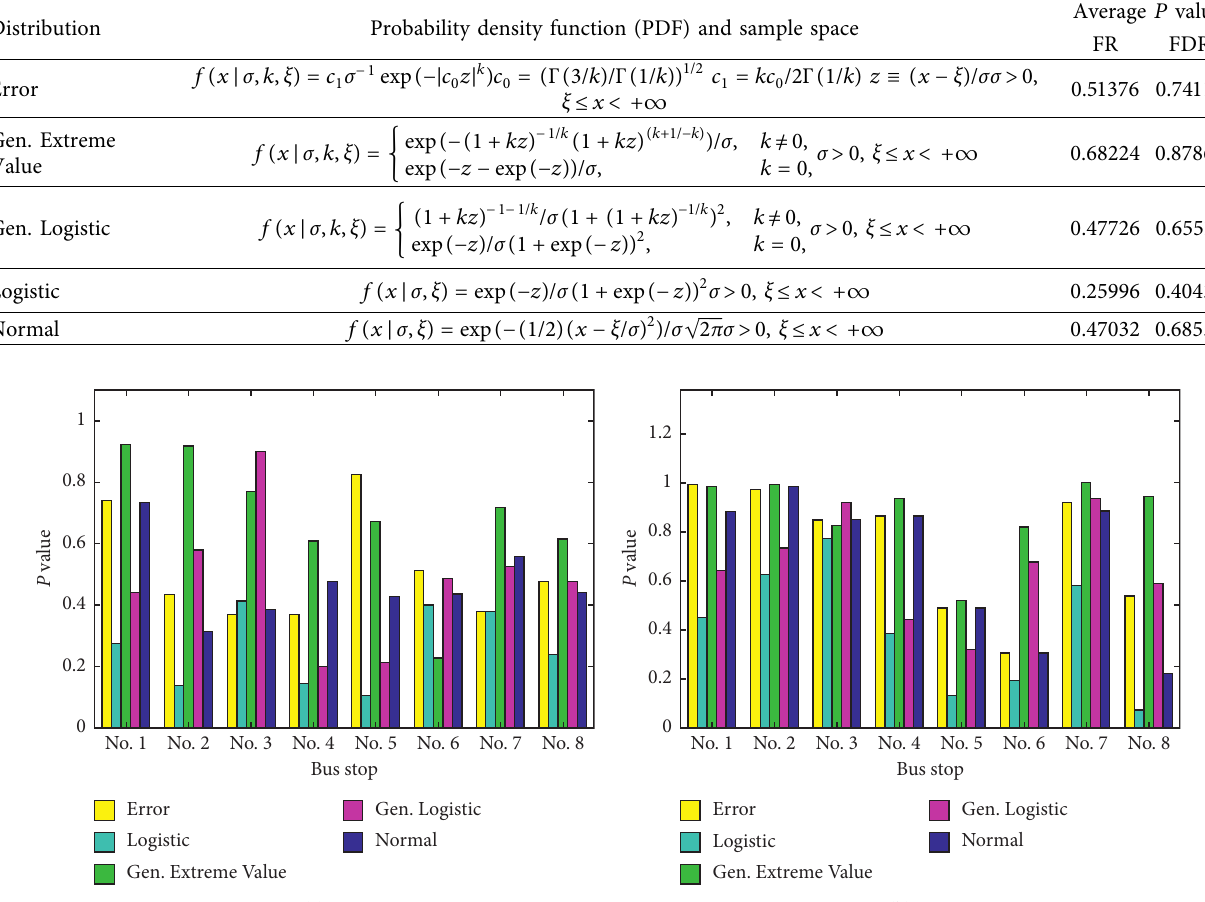
Table 5: Average P value of FR and FDR at test bus stops for well-fitted candidate distributions.